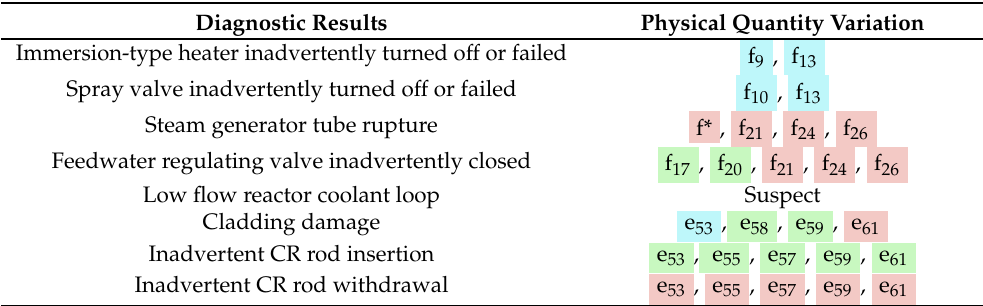
Table 12. Reasoning